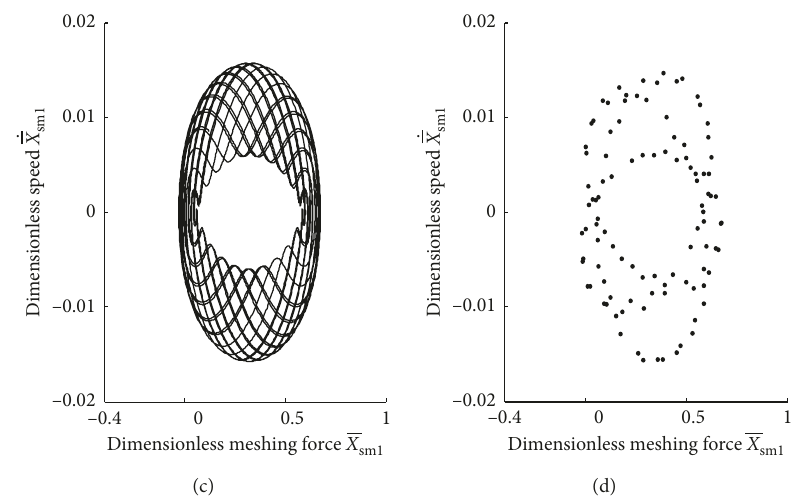
Figure 8: Process diagrams of response, phase diagram, and Poincar´e section under b � 70 μ m for encased stage. (a) Time process diagram of displacement response. (b) Time process diagram of meshing force response. (c) Phase diagram. (d) Poincar´e